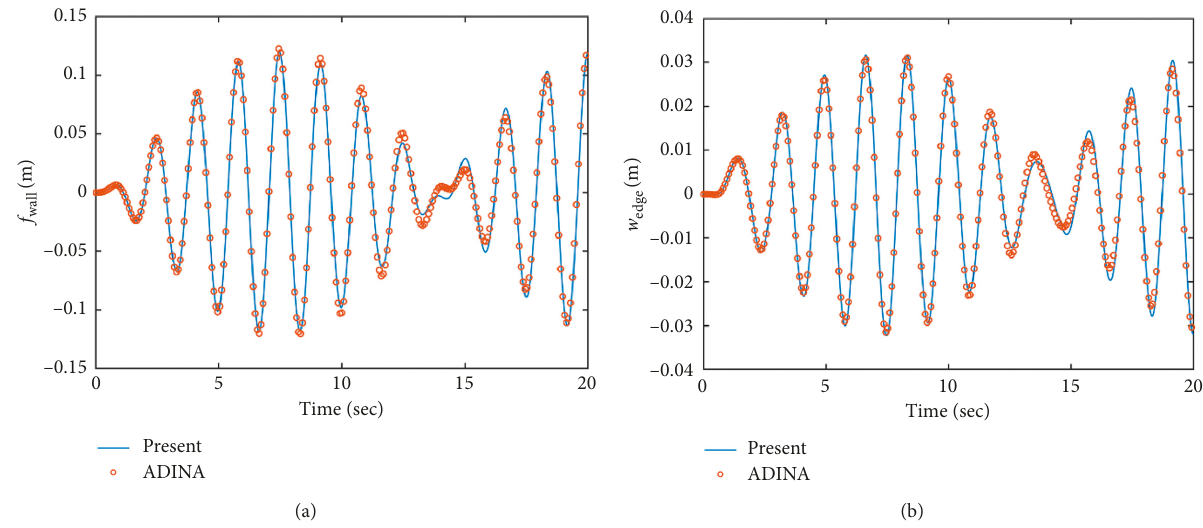
Figure 4: The time histories of the surface wave height on the wall ( θ � 0) and the dynamic deflection of the baffle at the inner edge ( θ � 0) � 4rad/s. (a) surface wave height on the wall, (b) dynamic deflection of the baffle at the inner for ω 0